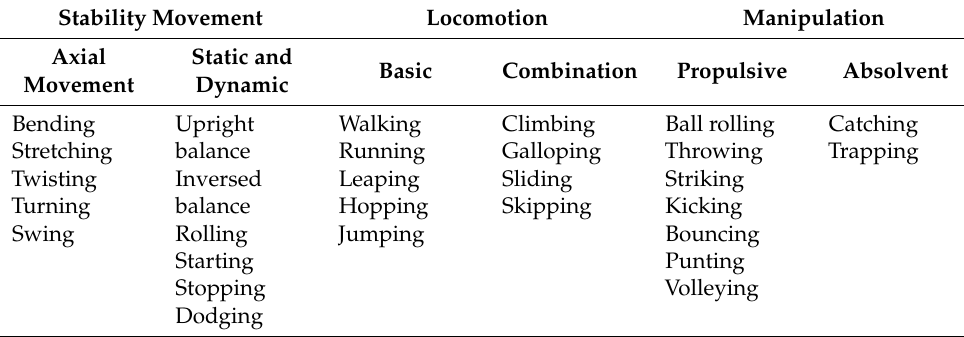
Table is adapted from developmental features of FMS proposed by Jeon